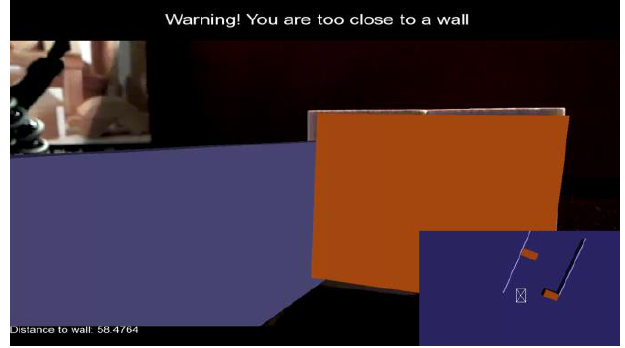
Figure 5. Image of the final view. In the image, the augmented view is displayed in the main window, showing virtual walls and obstacles over the real ones. The virtual reconstruction (a top view of the scene) is displayed as a HUD in the bottom right part of the window. Text messages including the distance to the wall (bottom left) and a warning message explaining the risk of collision (top) are also displayed on the